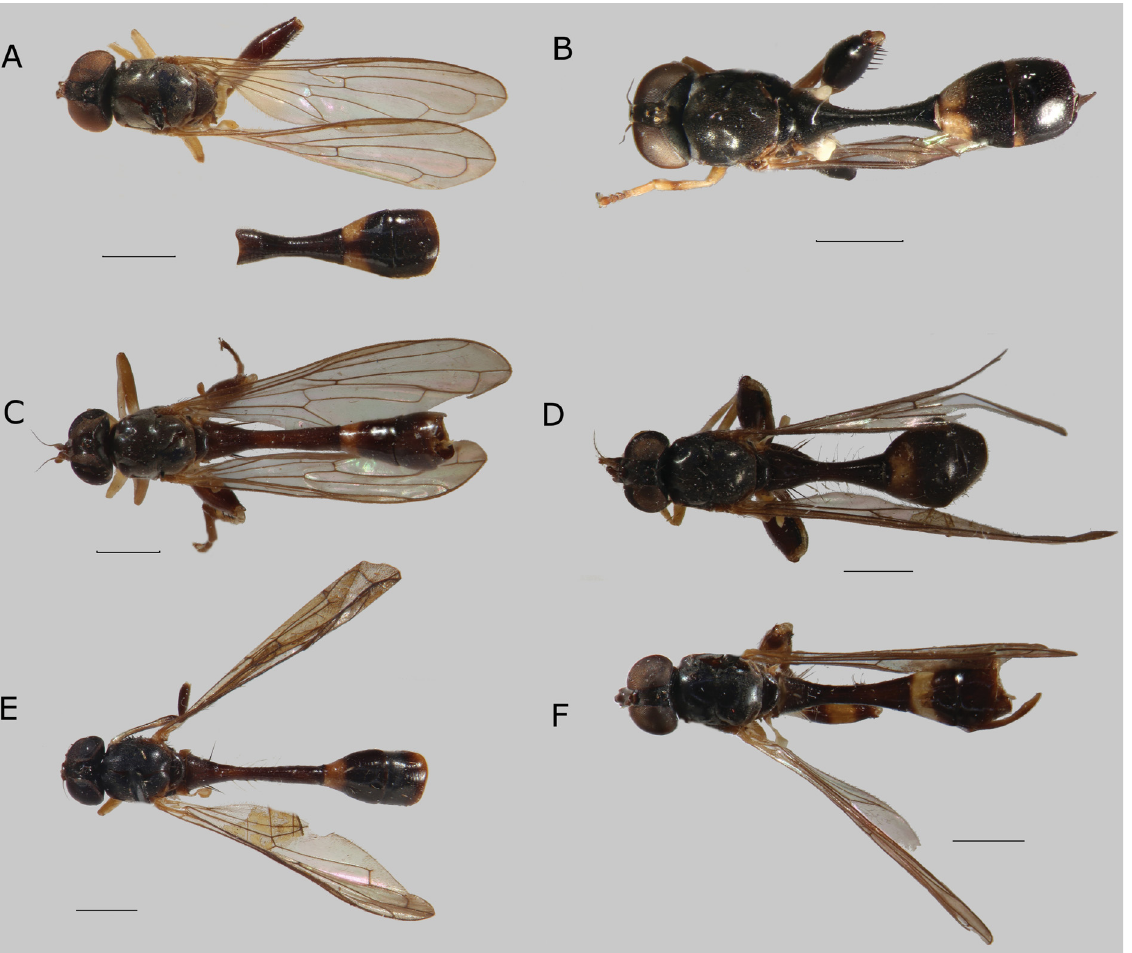
Fig. 79. Habitus, dorsal view. A . Sphegina (Asiosphegina) pollex Hippa, van Steeni s & Mutin,